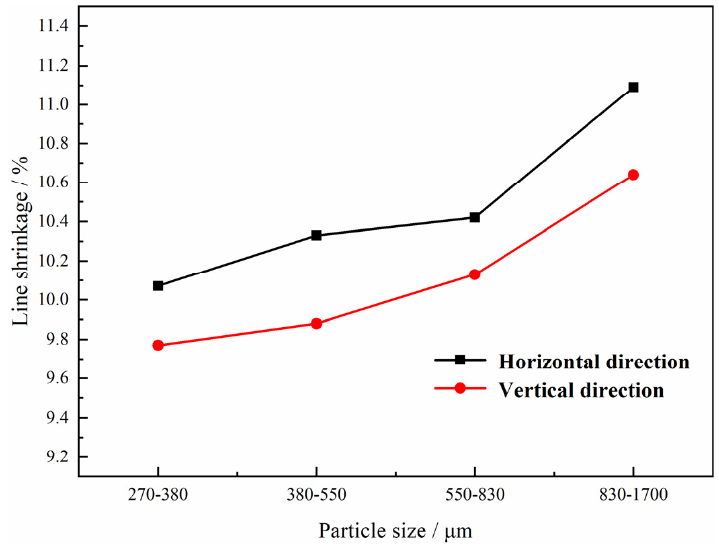
Figure 9. Relationship between line shrinkage and the size of magnesium particles.